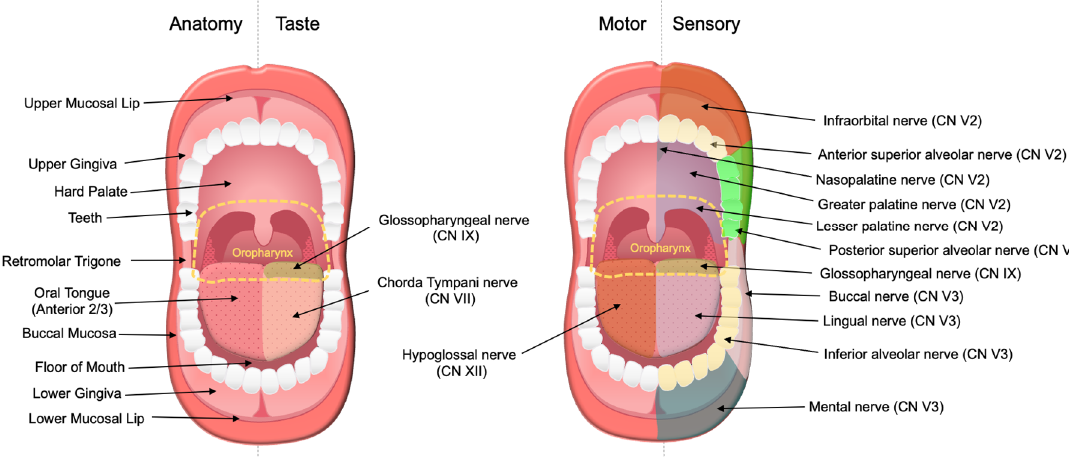
Figure 1. Nerves affected by perineural invasion in oral cavity cancer. The oral cavity cancer site consists of several subsites: oral tongue (anterior 2/3), floor of mouth, hard palate, retromolar trigone, buccal mucosa, upper and lower mucosal lip, and gingiva. The oral tongue (anterior 2/3) receives taste innervation from the chorda tympani (CN VII). The posterior 1/3 of the oral tongue belongs to the oropharynx and receives taste and sensory innervations by the glossopharyngeal nerve (CN IX). Motor innervation of the tongue is primarily supplied by the hypoglossal nerves (CN XII). Sensory innervation of the oral cavity is supplied by the maxillary (CN V2) and mandibular (CN V3) nerves. Perineural invasion in oral cavity cancer may involve any of the aforementioned nerves.